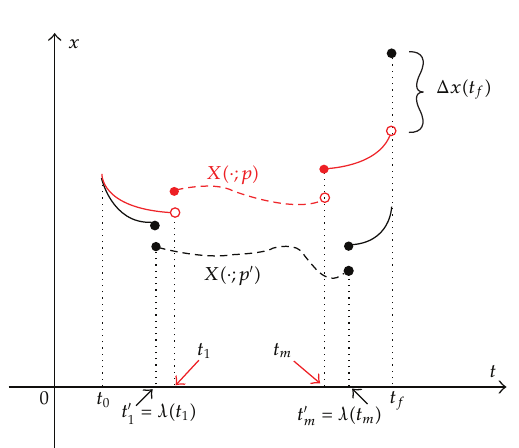
Figure 1: Comparison of two solutions with same initial data and di ff erent